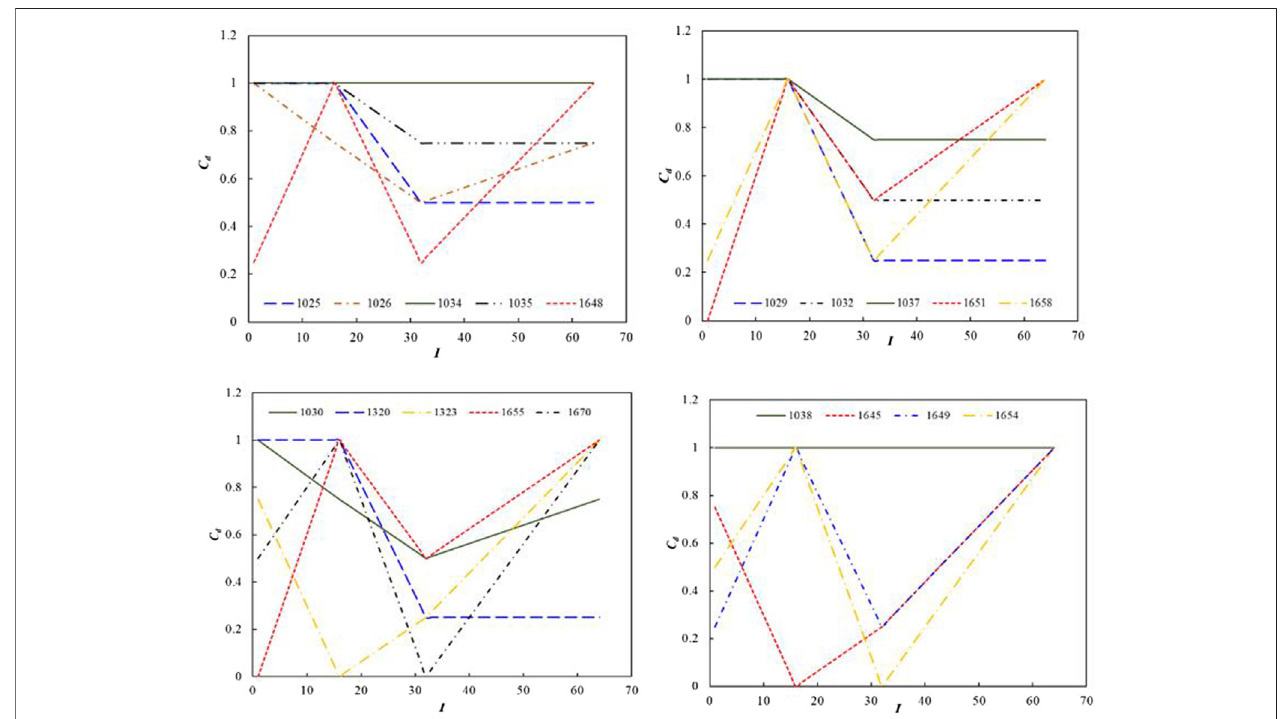
FIGURE 4 | Determination of rock pore structure ( C d path) by core NMR experiments.